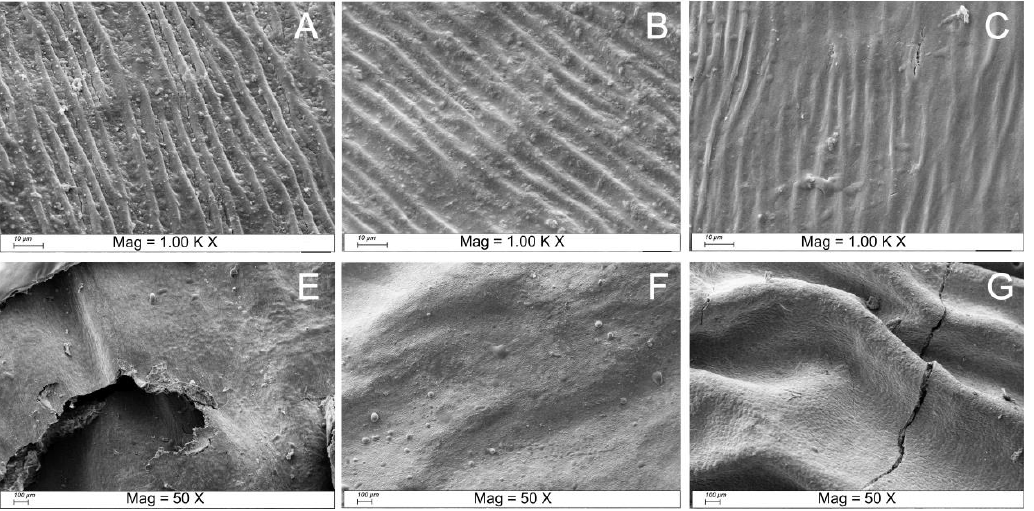
Figure 2. Scanning electron micrographs of the epidermal cells of DRI ( A , E ); WAT ( B , F ); and WIN ( C , G ) at different magnifications.